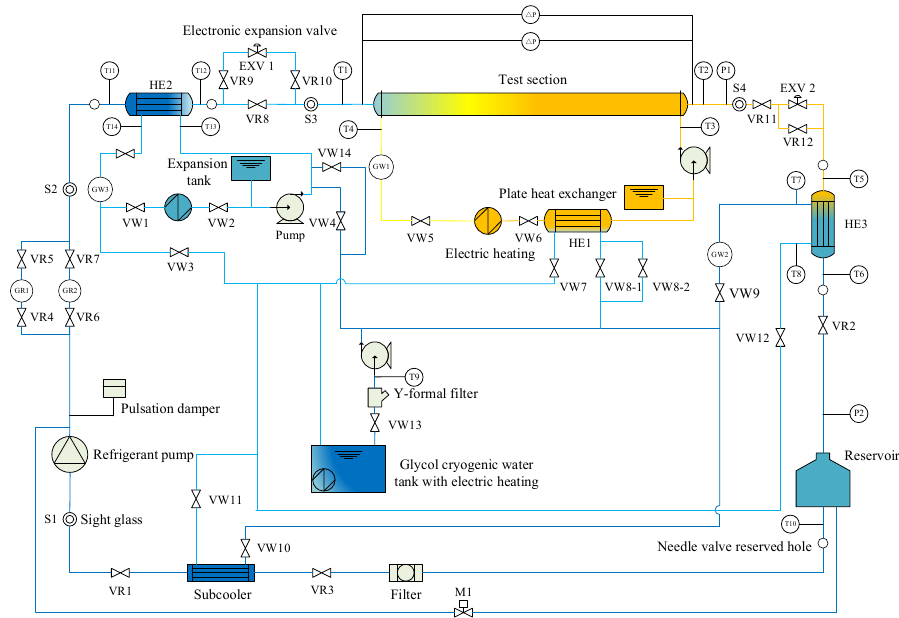
Figure 1. System schematic diagram of the single-tube heat exchange experimental platform [32].